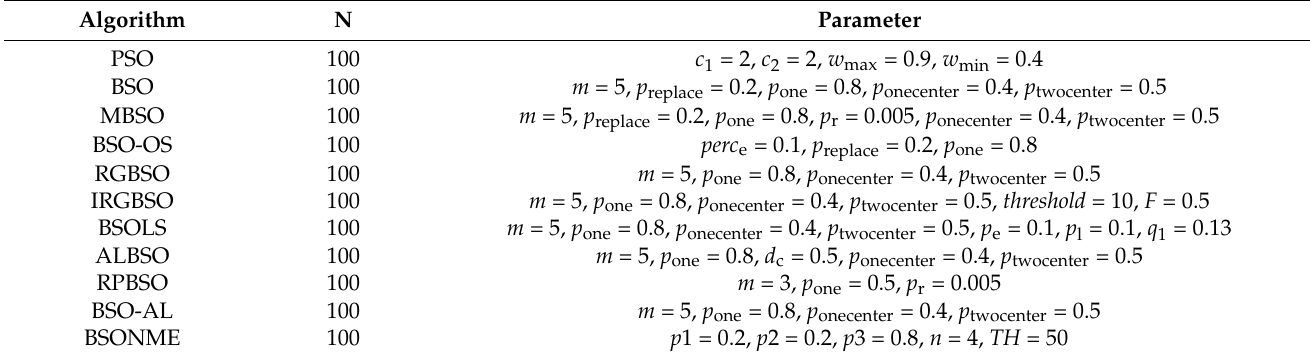
Table 4. Parameter settings of compared algorithms.